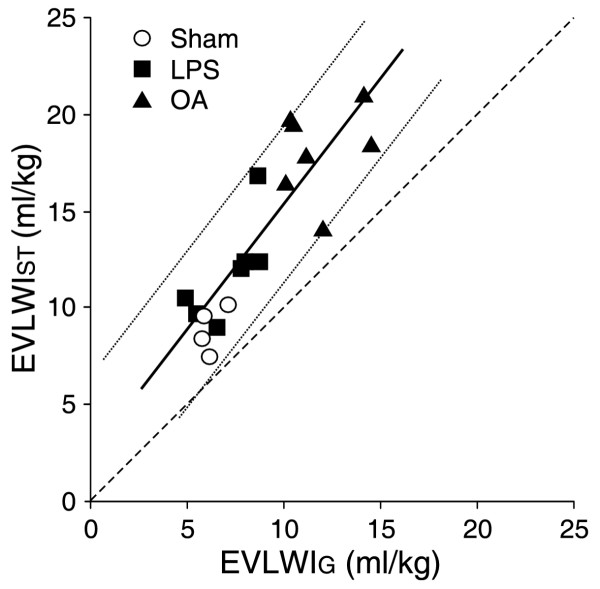
Linear regression analysis between extravascular lung water index (EVLWI) as determined by transpulmonary single thermodilution (EVLWIST) and postmortem gravimetry (EVLWIG) in sheep. EVLWIST = 1.30 × EVLWG + 2.32 (n = 18, r = 0.85, P < 0.0001). Line of identity is dashed; 95% confidence intervals are indicated by solid lines. LPS, lipopolysaccharide; OA, oleic acid; Sham, sham-operated.